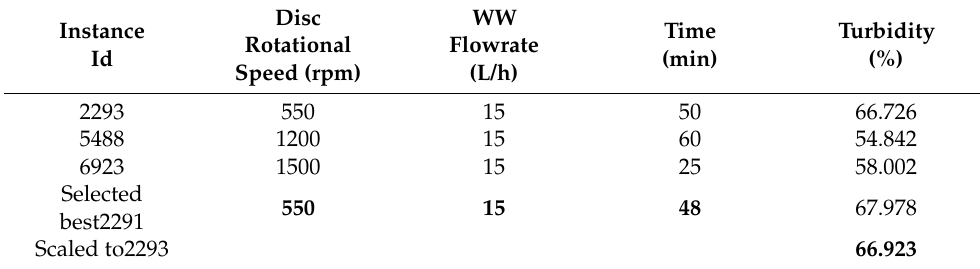
Table 7. Best values obtained by